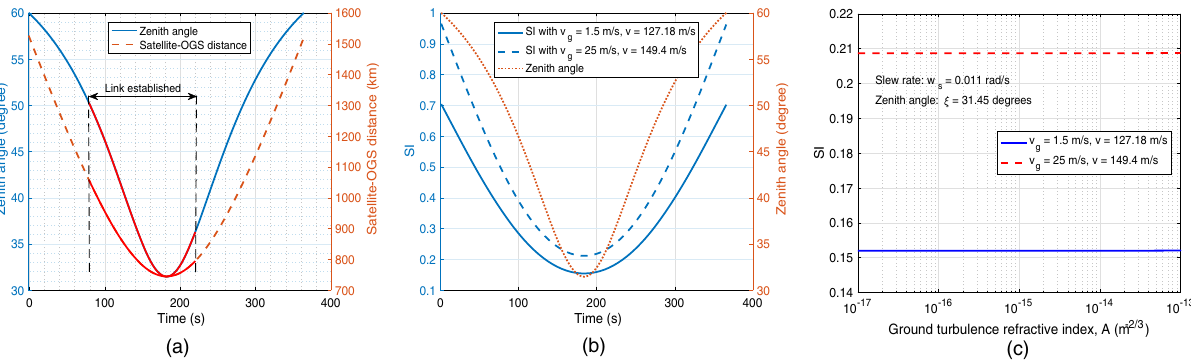
Fig. 1 Theoretical investigation of turbulence scintillation index using orbital data from the satellite pass on 5 August 2016. In a , zenith angle (solid navy-blue curve) and satellite-to-ground distance (dashed orange curve) are shown from the orbital data of SOCRATES satellite. The SOCRATES satellite was inserted in a Sun-synchronous near-circular sub-recurrent orbit at an altitude of 628 km with an inclination of 97.9° and a period of 97.4 min. Duration of established link is highlighted in red. In b , using the orbital data in a , the turbulence scintillation index (SI) for two different ground wind speeds (navy blue curves) and zenith angle (orange dotted curve) are plotted with ground turbulence refractive index A = 10 − 14 m − 2/3 . The solid navy-blue curve shows the turbulence SI when the ground wind speed v g = 1.5 m/s and root-mean-squared (rms) transverse wind speed v = 127.18 m/s, and the dashed navy-blue curve shows the turbulence SI when the ground wind speed v g = 25 m/s and rms transverse wind speed v = 149.4 m/s. In c , turbulence SI versus ground turbulence refractive index for two different wind speeds are plotted. The solid blue curve and the dashed red curve respectively depict the turbulence SI when the ground wind speeds v g = 1.5 m/s (i.e., rms transverse wind speed v = 127.18 m/s) and v g = 25 m/s (i.e., rms transverse wind speed v = 149.4 m/ s). In b and c , given parameters include wavelength λ = 0.85 μ m, optical ground station (OGS) altitude H OGS = 122 m, minimum zenith angle ξ min ¼ 31 :